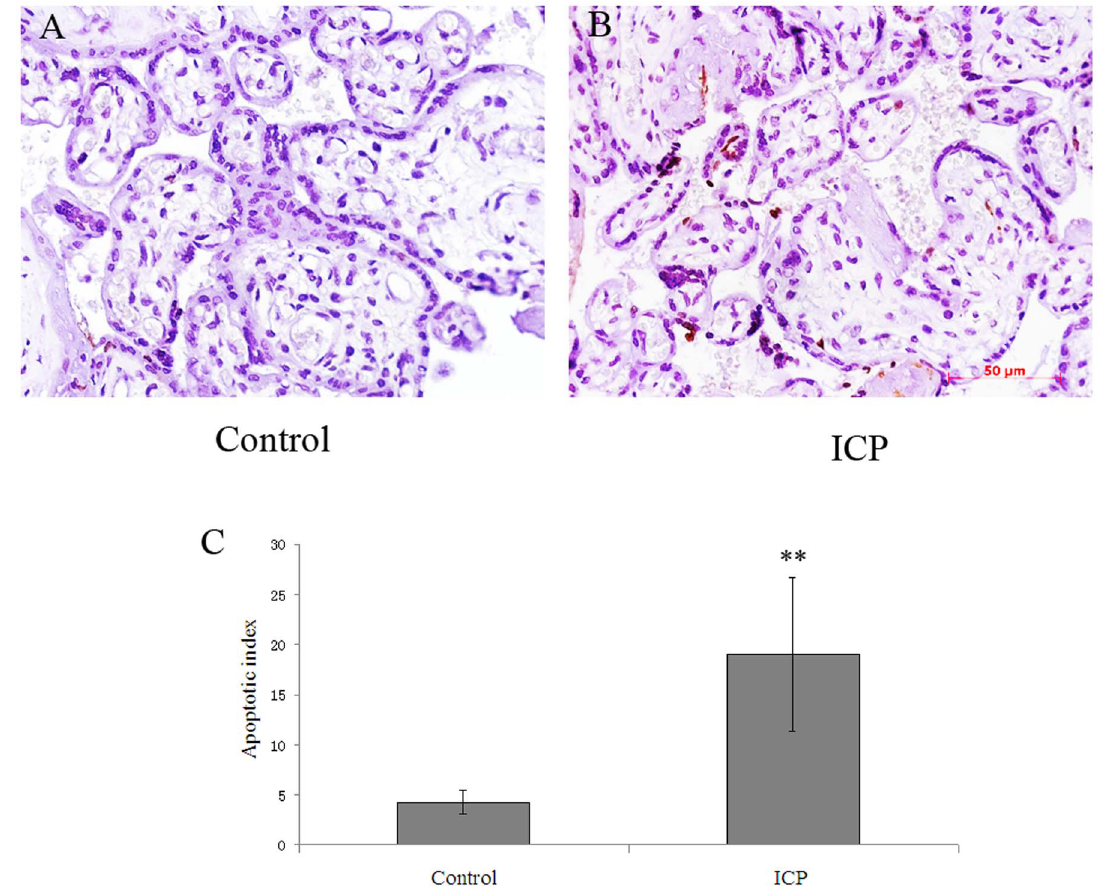
Figure 5. Comparison of the incidence of apoptosis in placenta from pregnant women with ICP compared to that in placenta from healthy pregnant women ( 6 400). TUNEL assay demonstrated the incidence of apoptosis in placenta from pregnant women with ICP was higher than that in placenta from healthy pregnant women (A and B). Semi-quantitative analysis indicated there was significantly higher incidence of apoptosis in placenta from pregnant women with ICP ( P =0.007) (C).